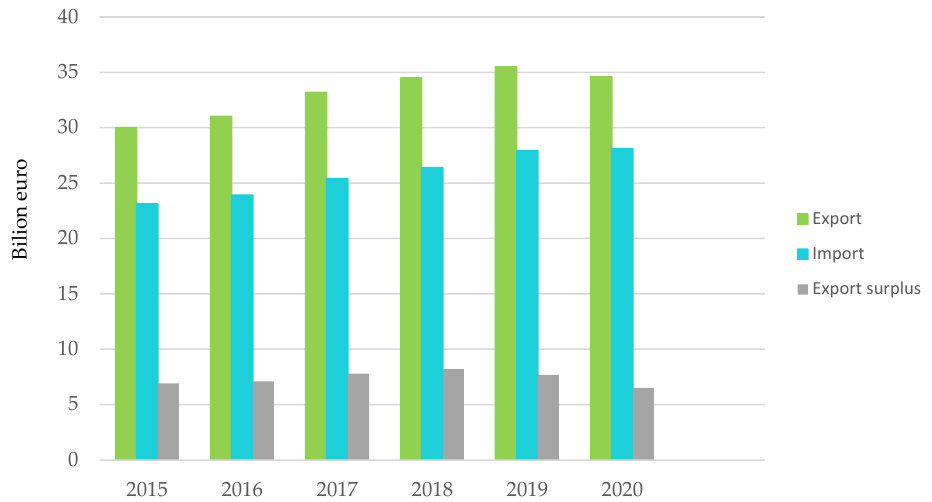
Figure 3. Plastics processing and trade balance with non-EU27 countries. Made based on [3].